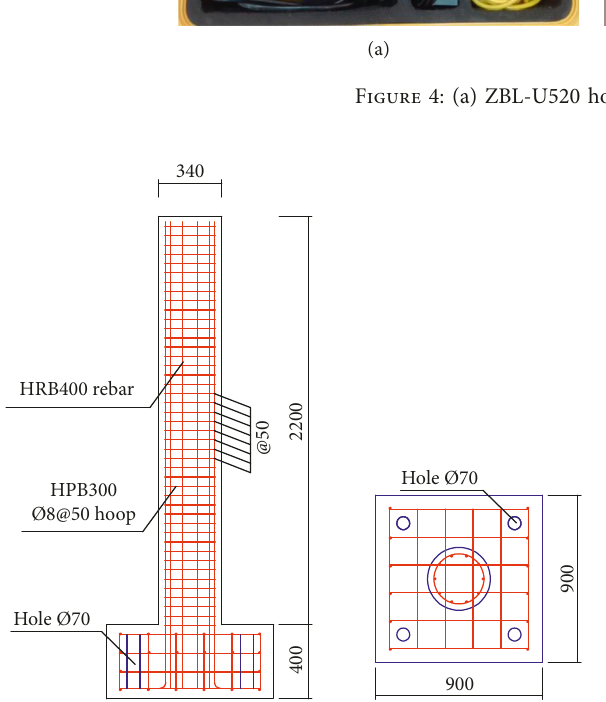
Figure 5: Schematic diagram of the specimens’